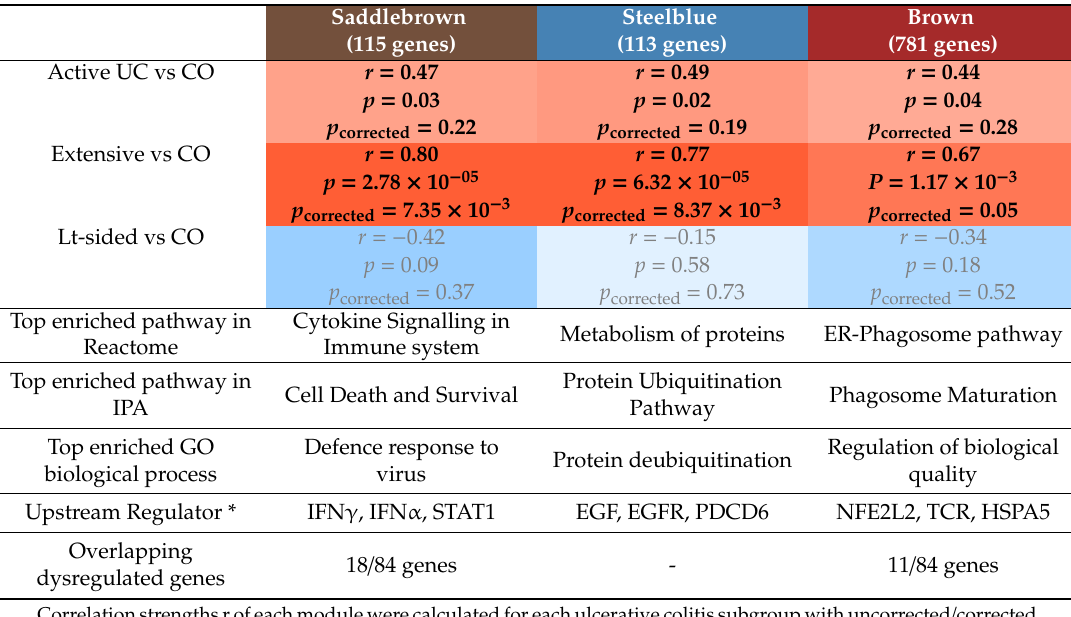
Table 4. Significantly correlated co-expression modules in active ulcerative colitis.